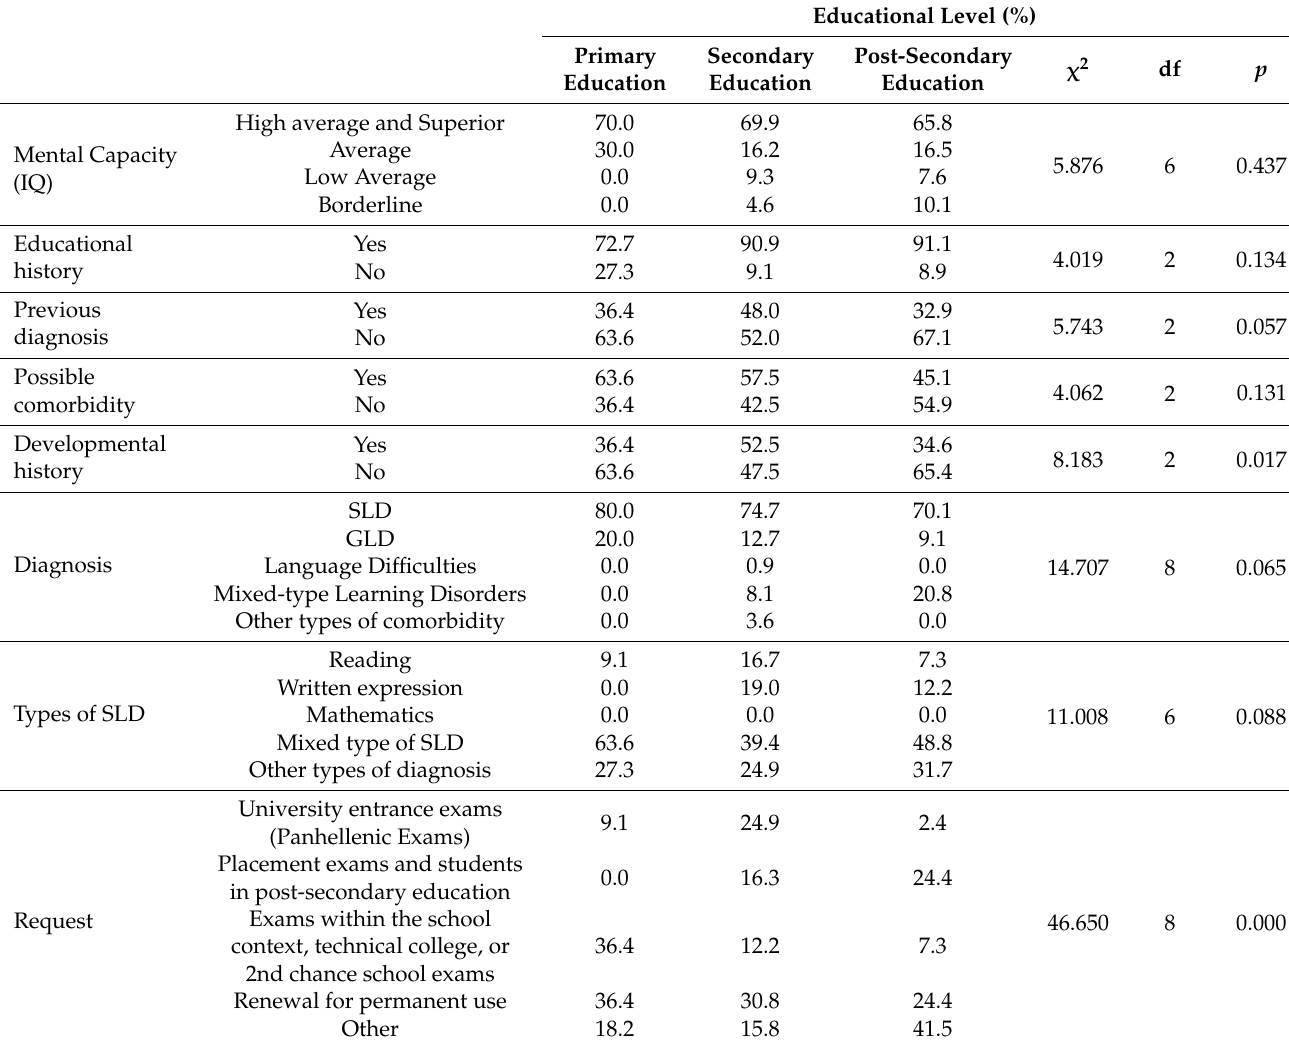
Table A9. Relationship of the Educational level of the assessed adults with the other variables.